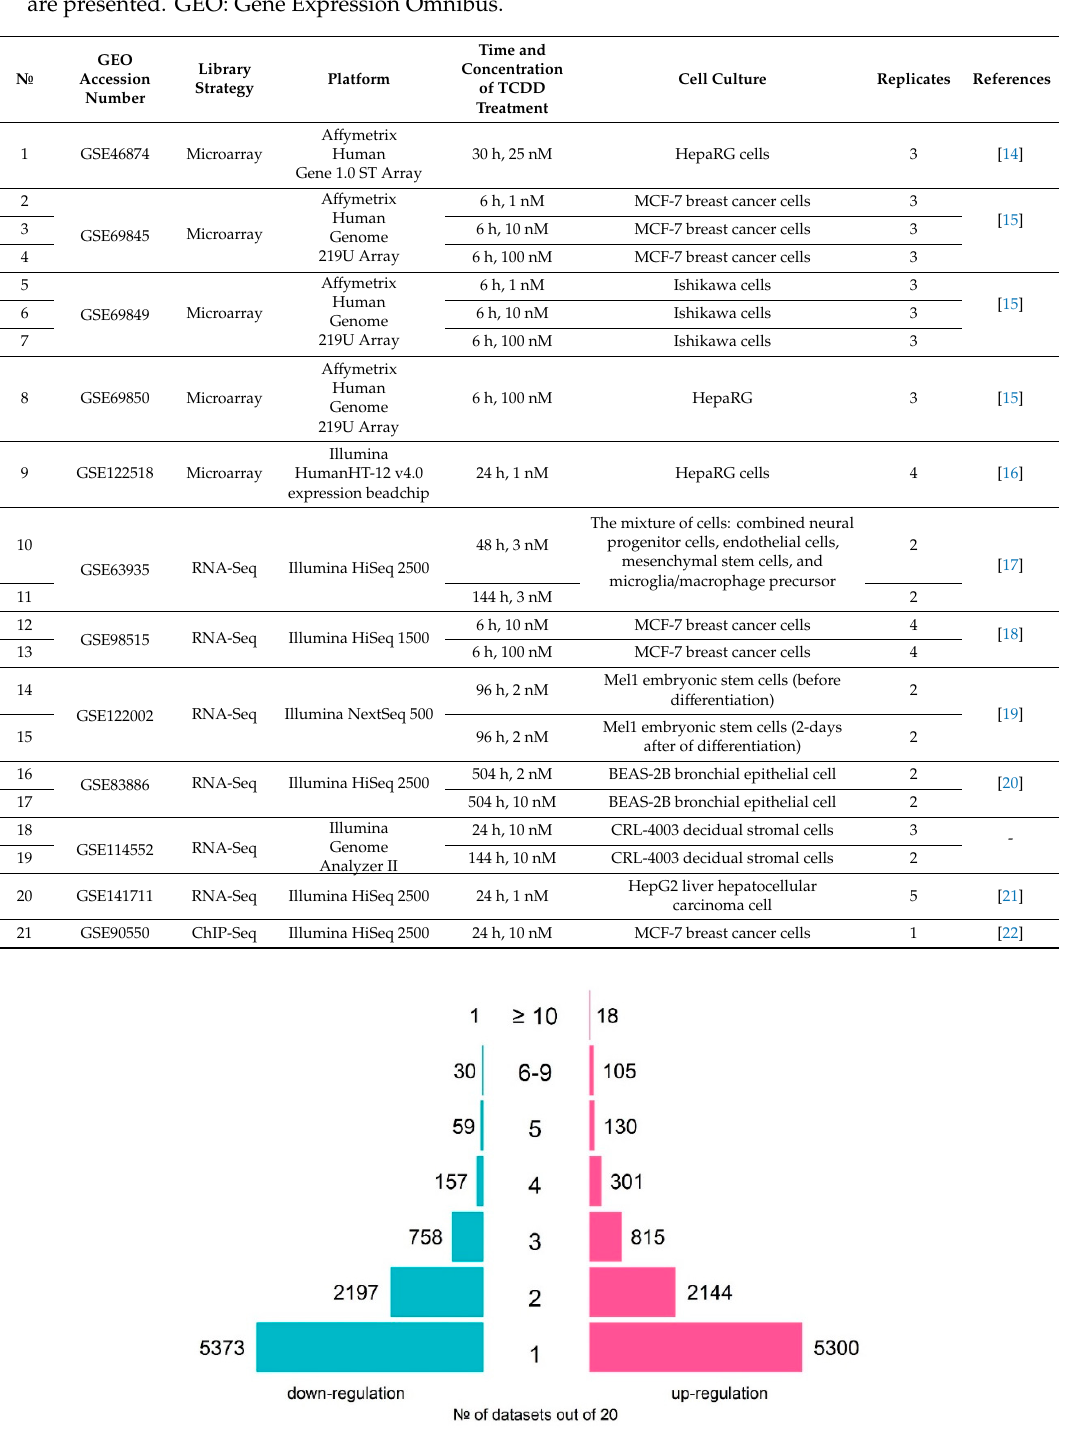
Figure 1. An overview of the numbers of TCDD-responsive genes over 20 analyzed transcriptomes on human cell lines: number of up-regulated genes (pink rectangles) and number of down-regulated genes (blue rectangles).